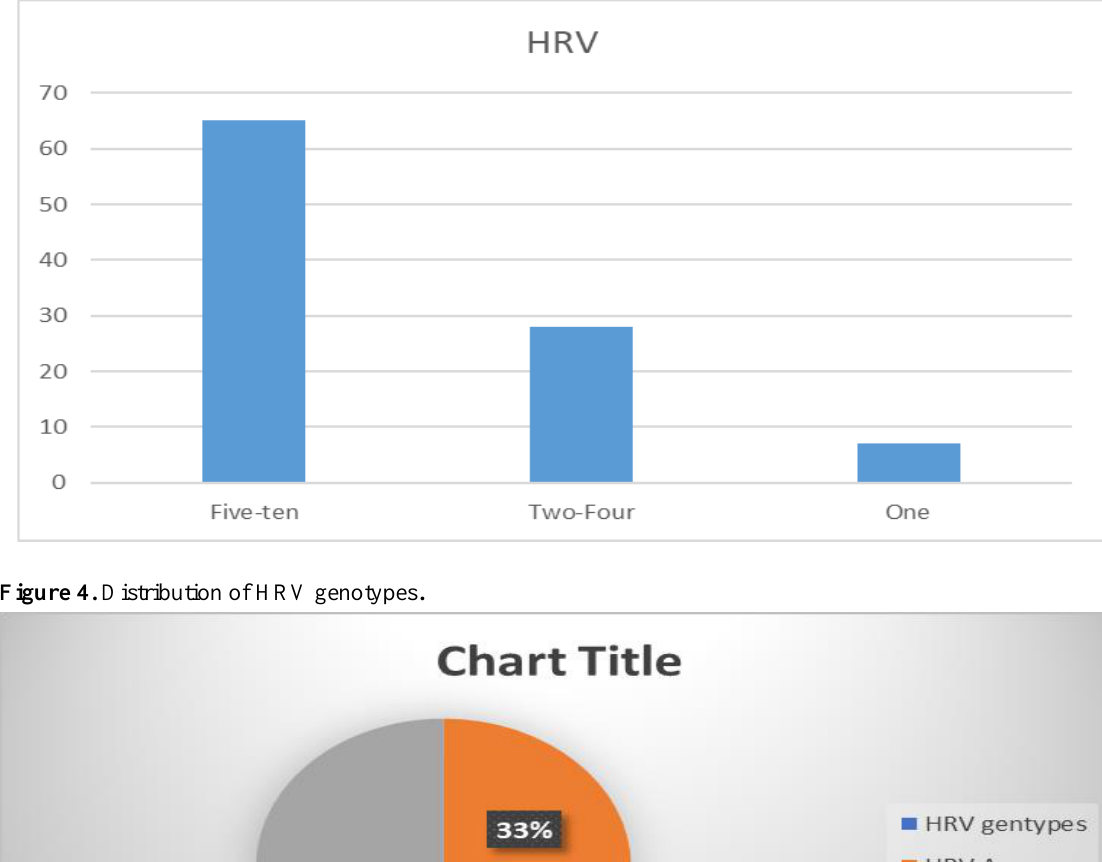
Figure 3. Distribution of HRV among different age groups .